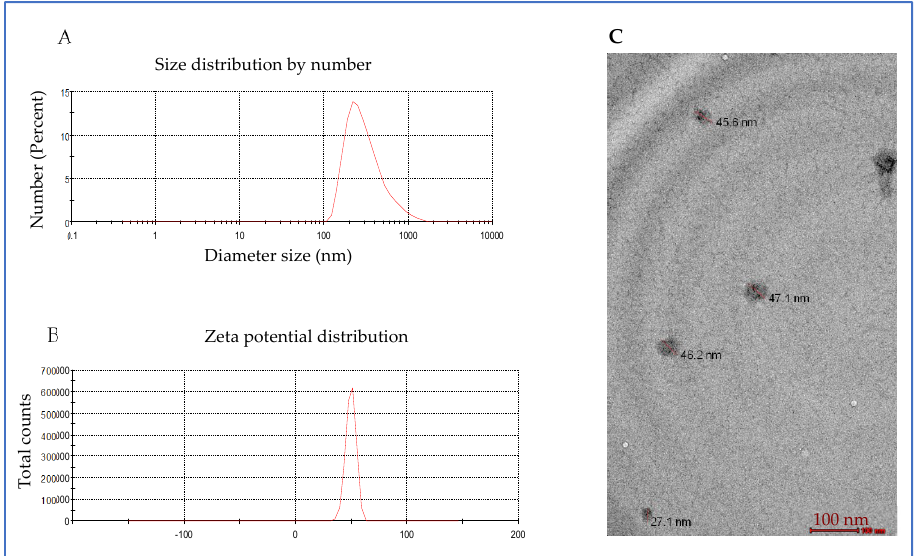
Figure 2. C-TPP NPs characterization ( A ) particle diameter size distribution, ( B )Zeta Potential, ( C ) transmission electron microscope (TEM) images.